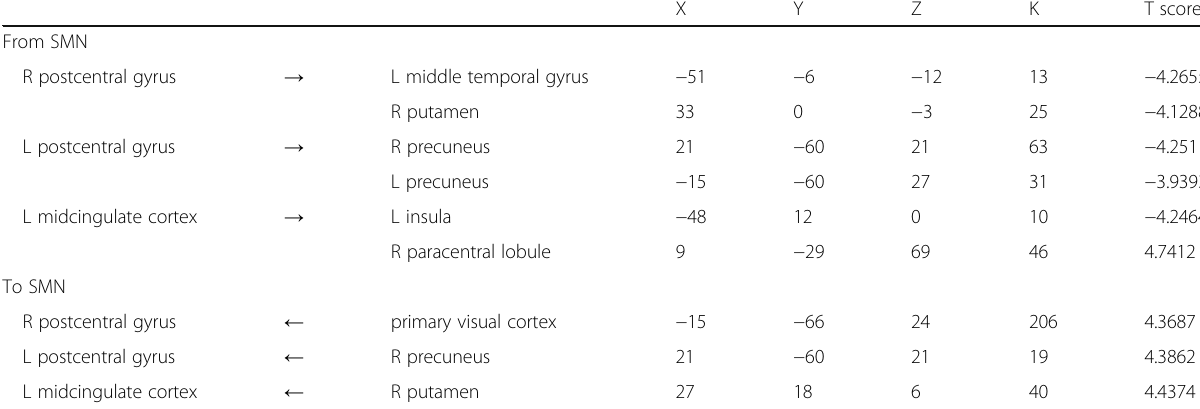
Table 3 Altered effective connectivity between SMN and rest of brain in MwoA compared with healthy controls